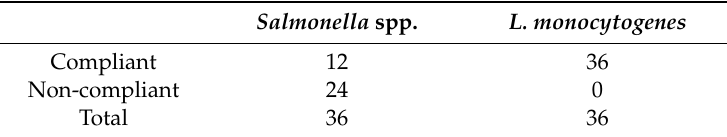
Table 2. Ready-to-eat leafy green salad batches acceptability according to European Regulation (EC) No 1441 / 2007 safety criteria: for Salmonella spp. absence in 25 g, for L. monocytogenes lower than 100 colony forming units (CFU) /